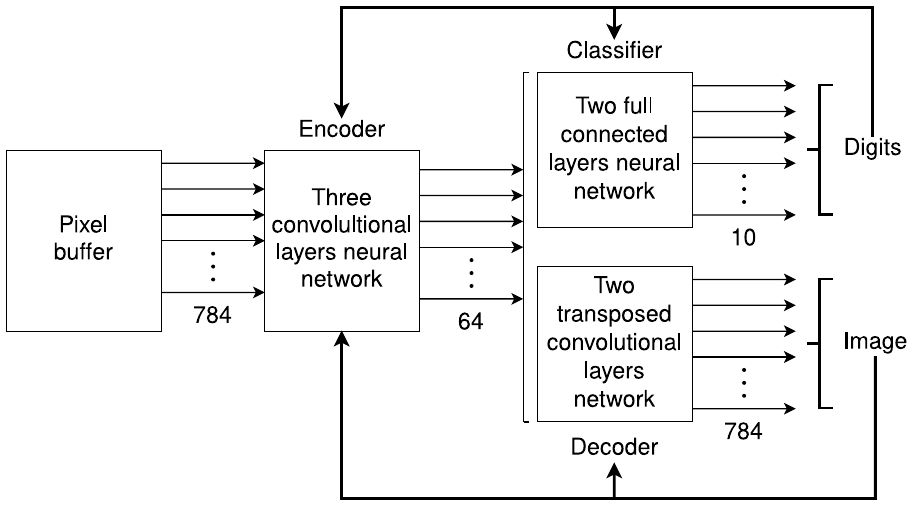
Figure 2. Training the analysis and synthesis